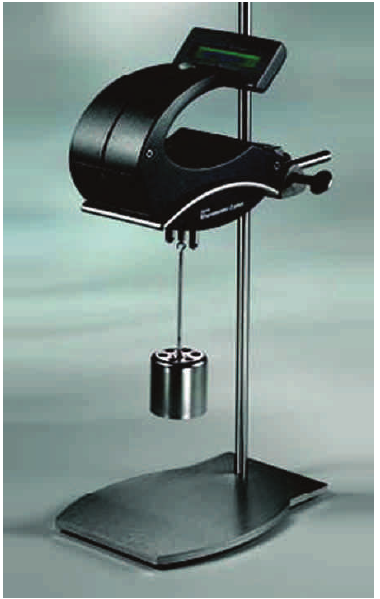
Fig. 1. General view of portable rotational viscometer VT1 Plus type produced by HAAKE